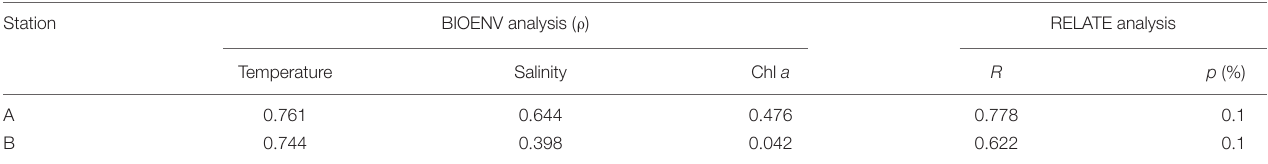
Station BIOENV analysis ( ρ ) RELATE